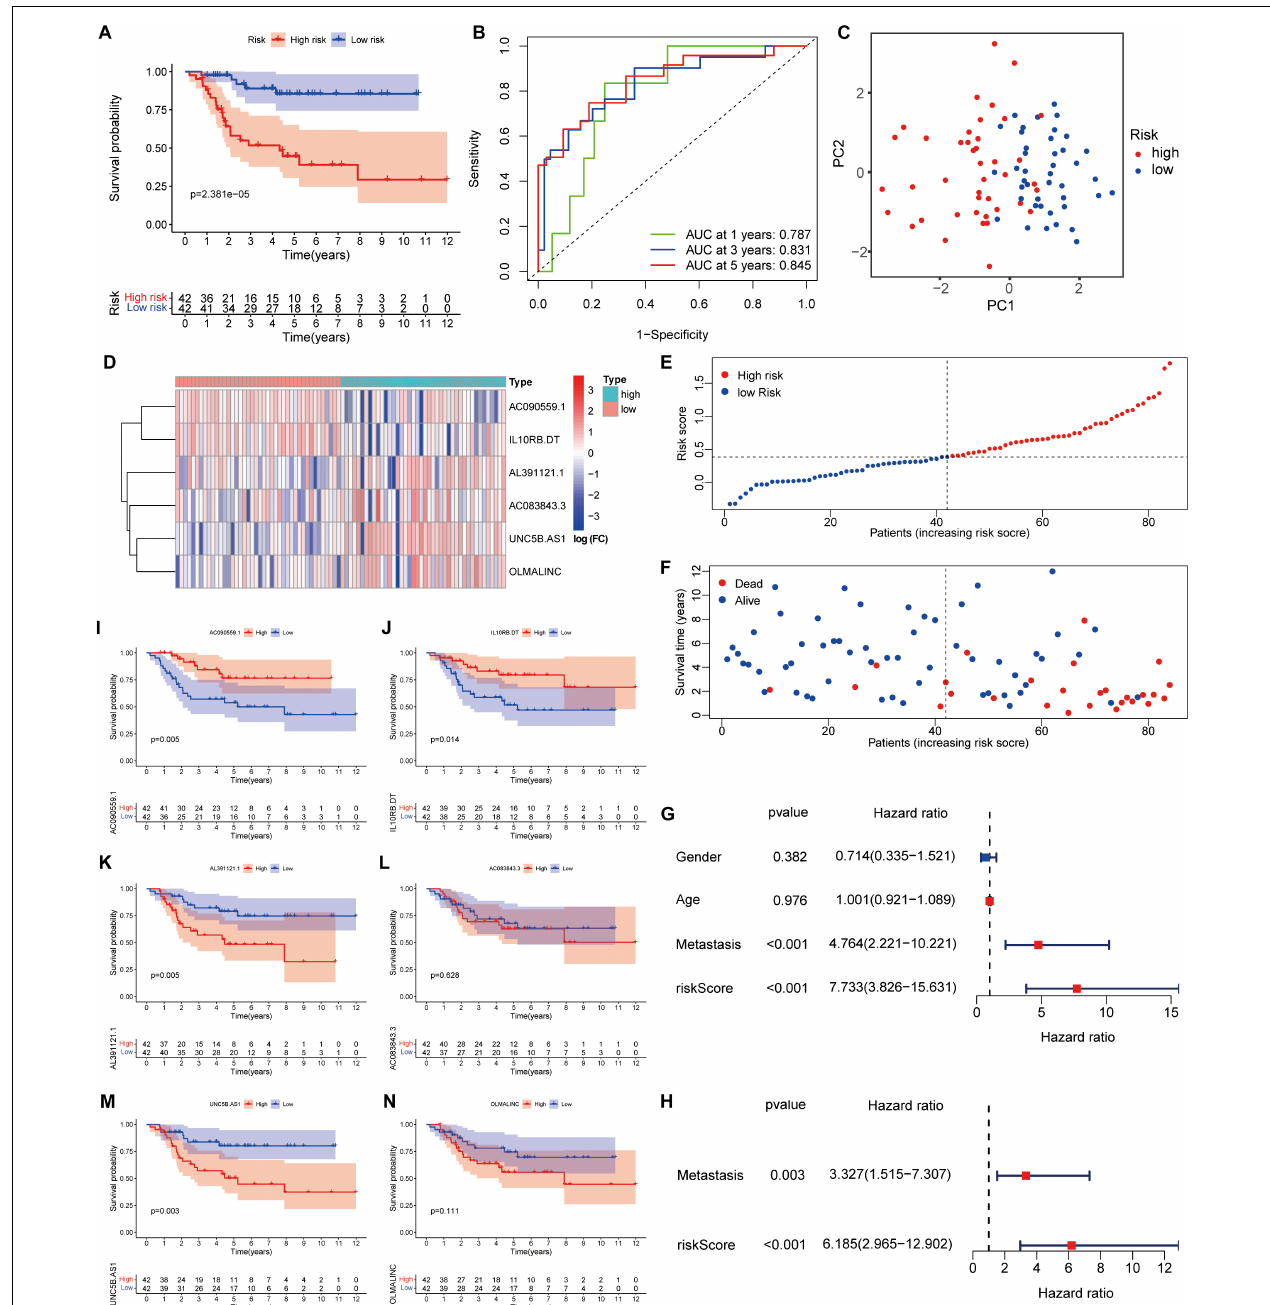
FIGURE 2 | A risk signature with the six autophagy-related lncRNA. (A) Kaplan–Meier survival curve analysis. (B) The AUC for the prediction of 1, 3, 5-year survival rate. (C) PCA based on the autophagy-related long noncoding RNAs (lncRNAs) signature. (D) Heatmap of the six key lncRNAs expressed between the high and low risk group. (E,F) Risk score analysis of the signature. (G,H) Univariate and multivariate cox analysis. (I–N) Kaplan–Meier survival curves for the six prognostic lncRNAs in TARGET